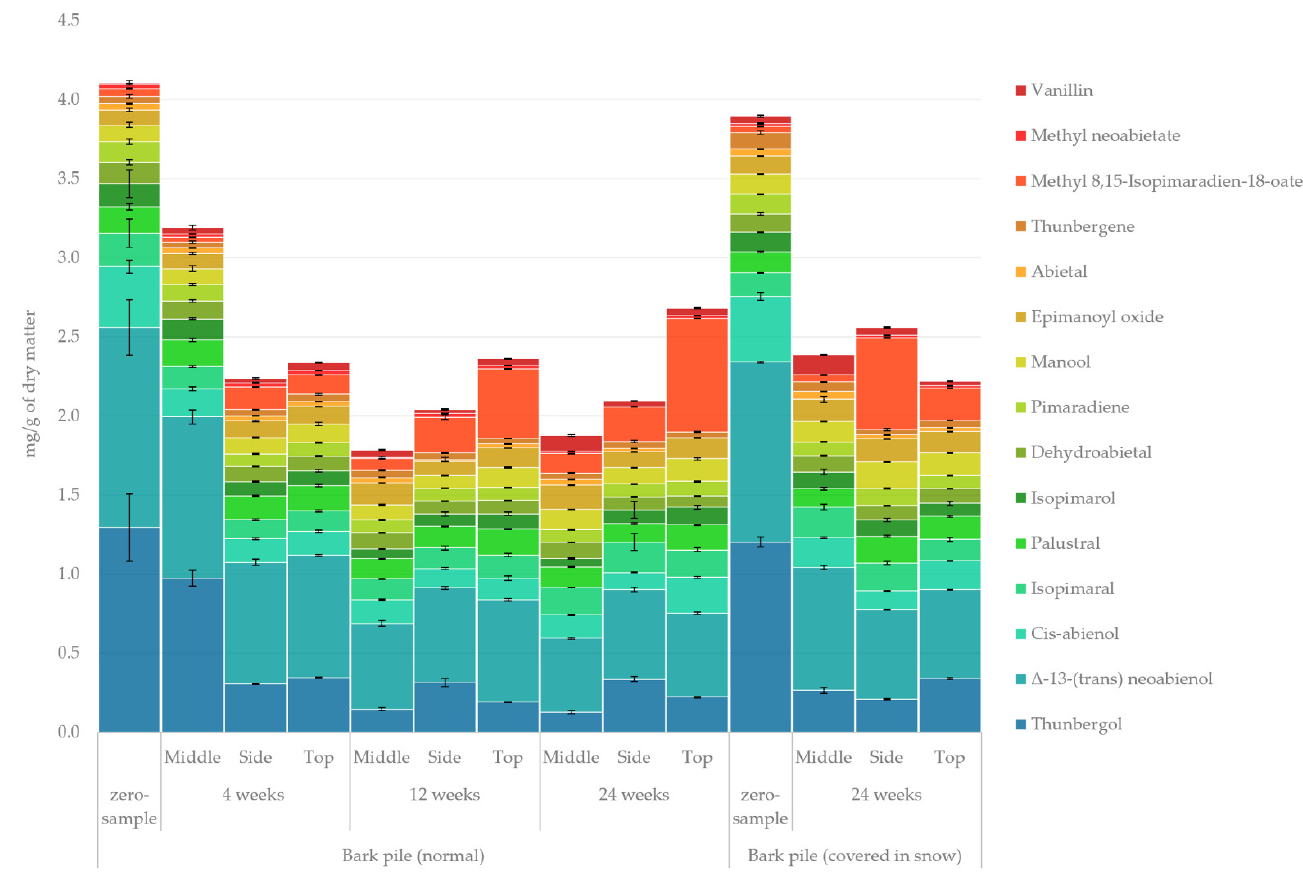
Figure 7. Quantified amounts of individual diterpenoids in the lipophilic extracts of the stored